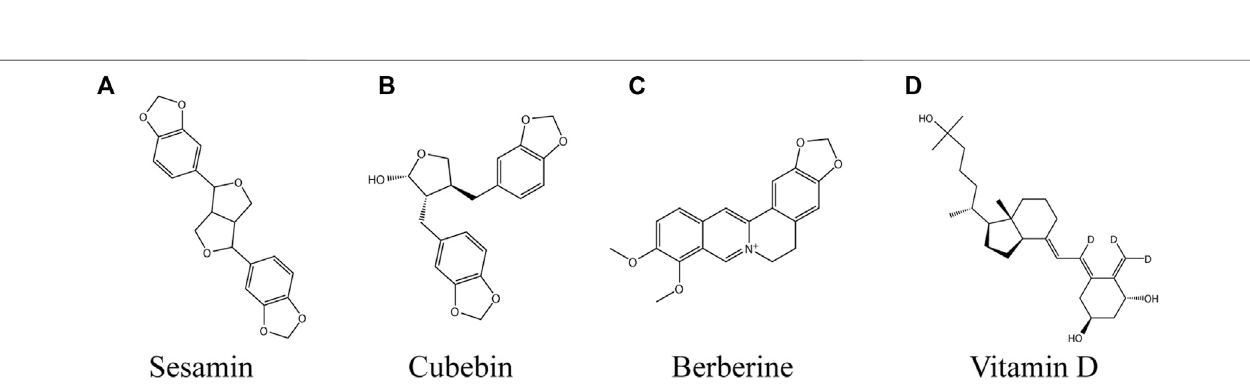
FIGURE 7 | Coumarins against vitiligo (A) Sesamin, (B) Cubebin, (C) Berberine, (D) Vitamin D.